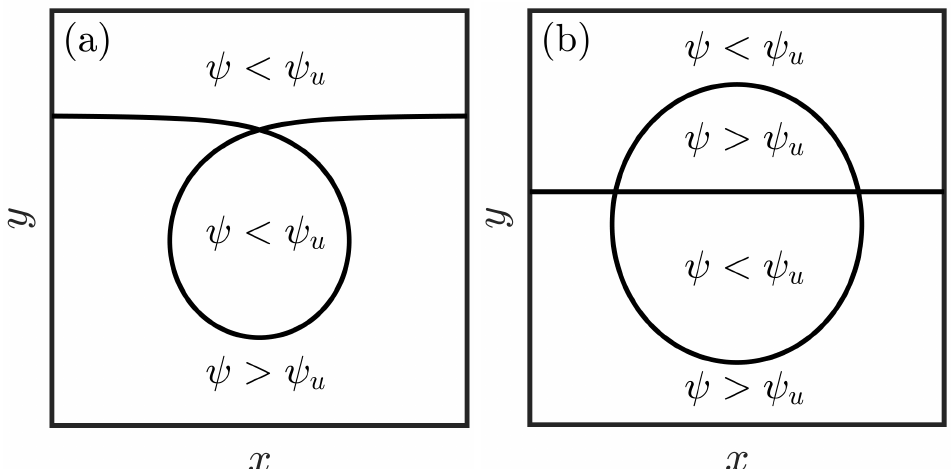
Figure 7. Schematic illustrating the geometry of the streamfunction values and the structure of the invariant manifolds at a fixed height z defining the trapped volume in the ( a ) homoclinic and ( b ) heteroclinic regime for z < 0. For z > 0, the structures are flipped across y = 0, and regions inside heteroclinic separatrices display the same pattern of streamfunction values, but regions inside homoclinic separatrices have ψ > ψ u . Here, ψ u is the streamfunction value at an unstable fixed point. Note that when Z = 0, there is no homoclinic regime, the trapped volume is symmetric about all three coordinate planes, and ψ u =